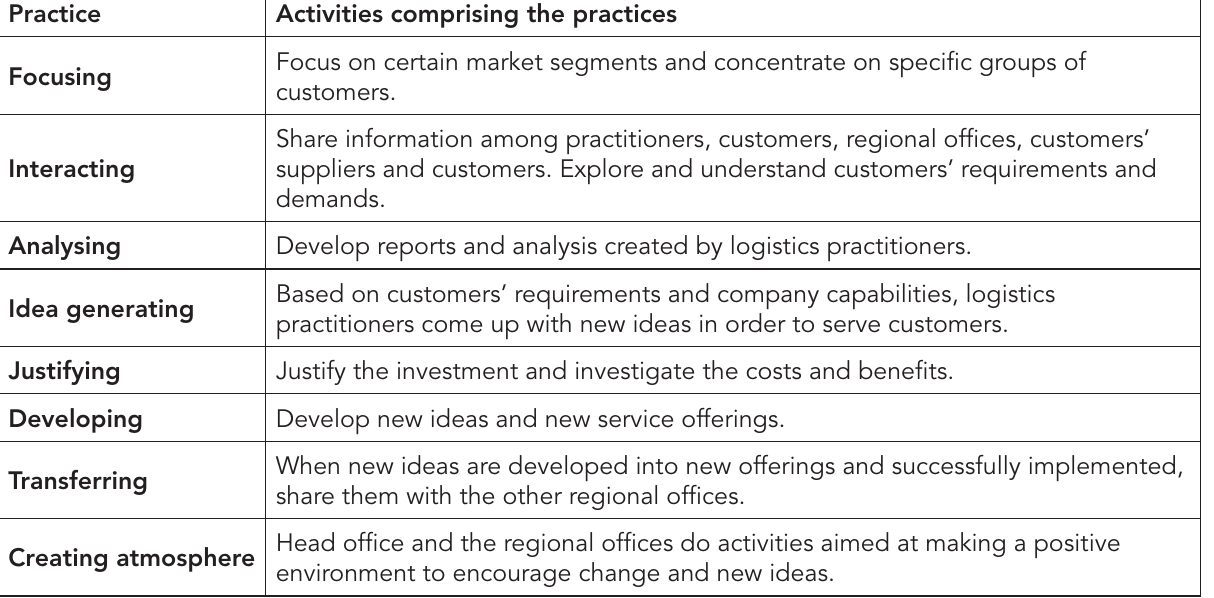
Table I: Practices and activities carried out by logistics practitioners during strategising in the multinational logistics